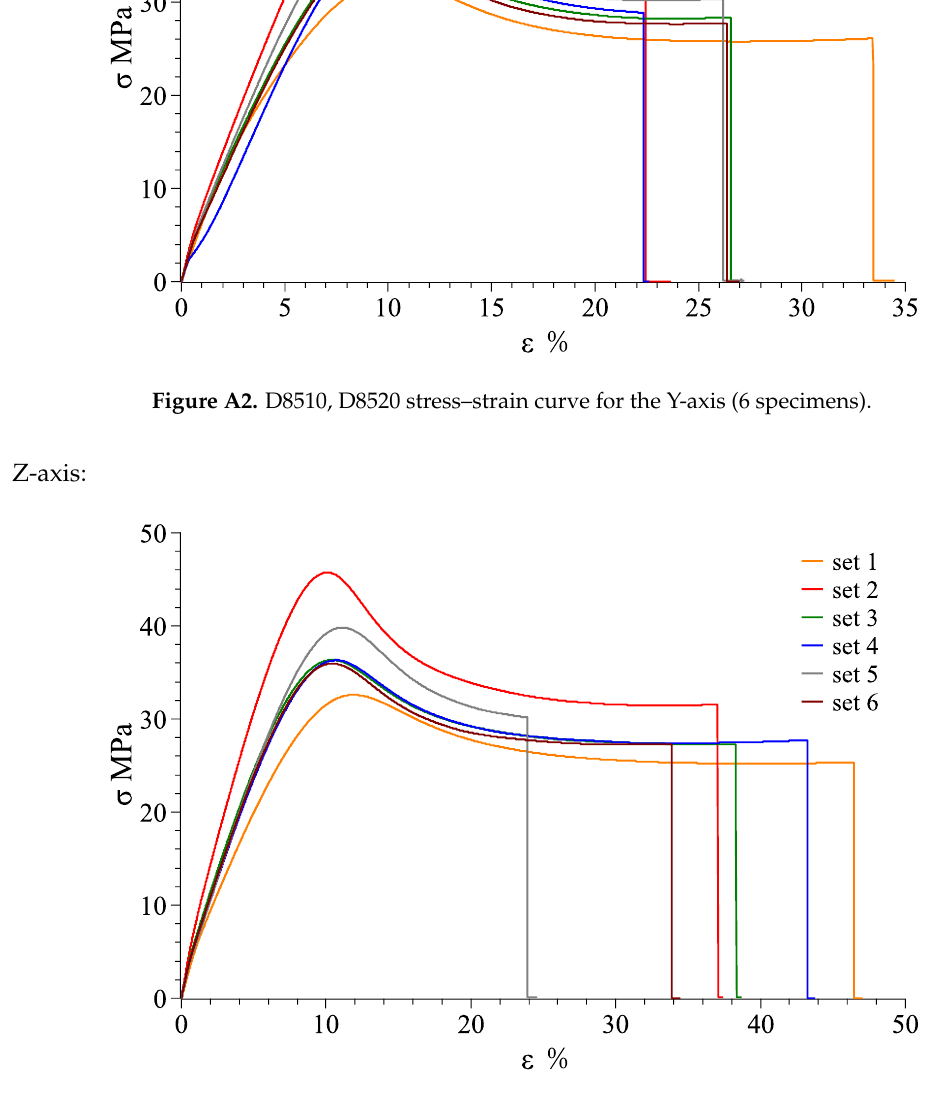
Figure A3. D8510, D8520 stress–strain curve for the Z-axis (6 specimens).